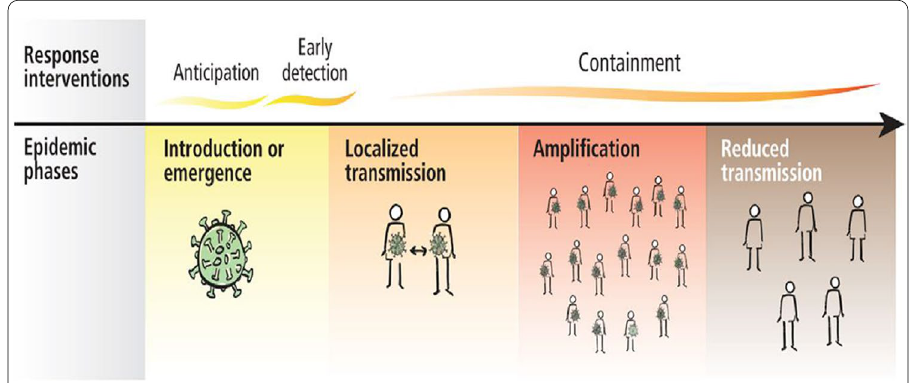
Fig. 1 Spread of contiguous disease and with solution